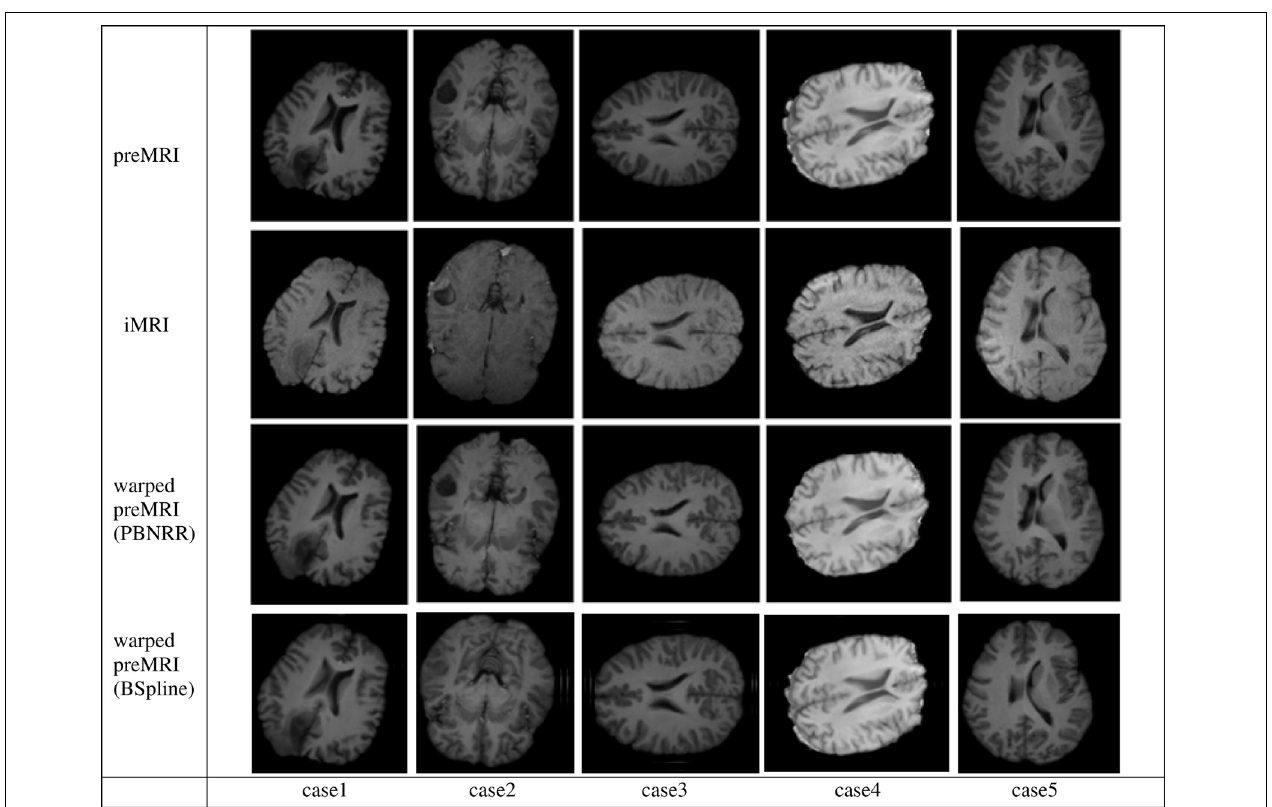
FIGURE 5 | TheQualitativeresultsforthefivecasesofthePBNRRfilter. Eachcolumncorrespondstoadifferentcase,andeachrowfromthetoptothebottom: the preoperative MRI, the intra-operative MRI, and the warped preoperative MRI using PBNRR and the warped preoperative MRI using BSpline based NRR.